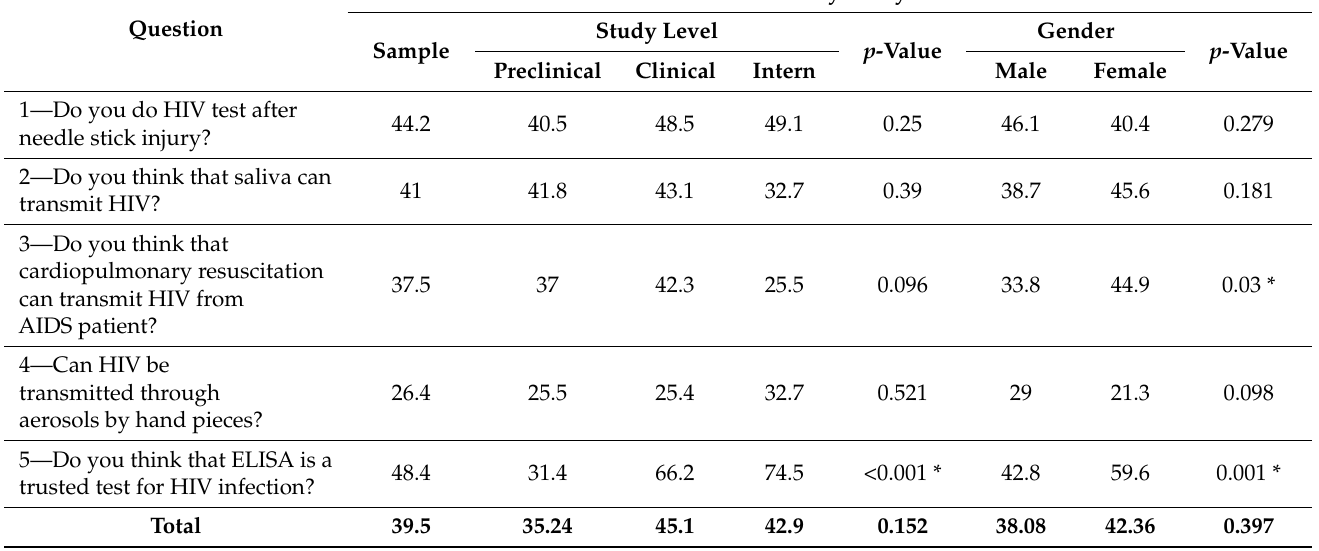
Table 2. Response of participants to safety-related questions about HIV by gender and study level (no =